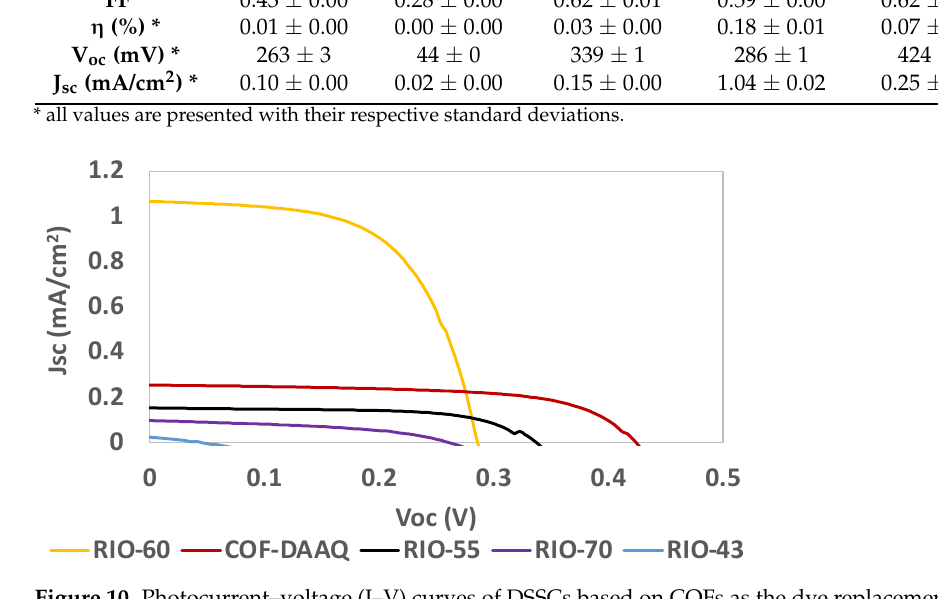
Figure 10. Photocurrent–voltage (J–V) curves of DSSCs based on COFs as the dye replacement under simulated AM 1.5 G illumination at 100 mW/cm 2 .